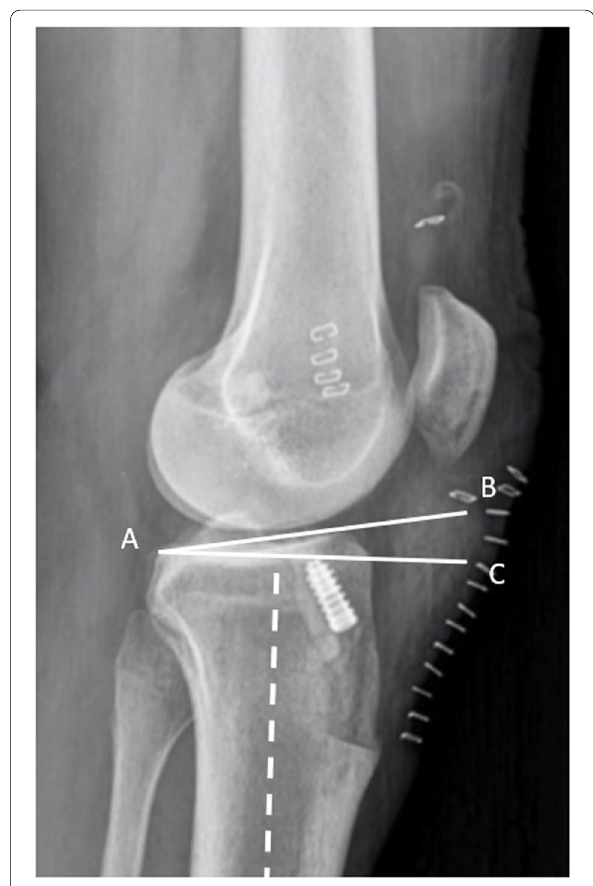
Fig. 1 The lateral posterior tibial slope, that is the angle between the tangential line to the surface of the lateral tibial plateau (line AB) and the perpendicular to the tibial axis (line